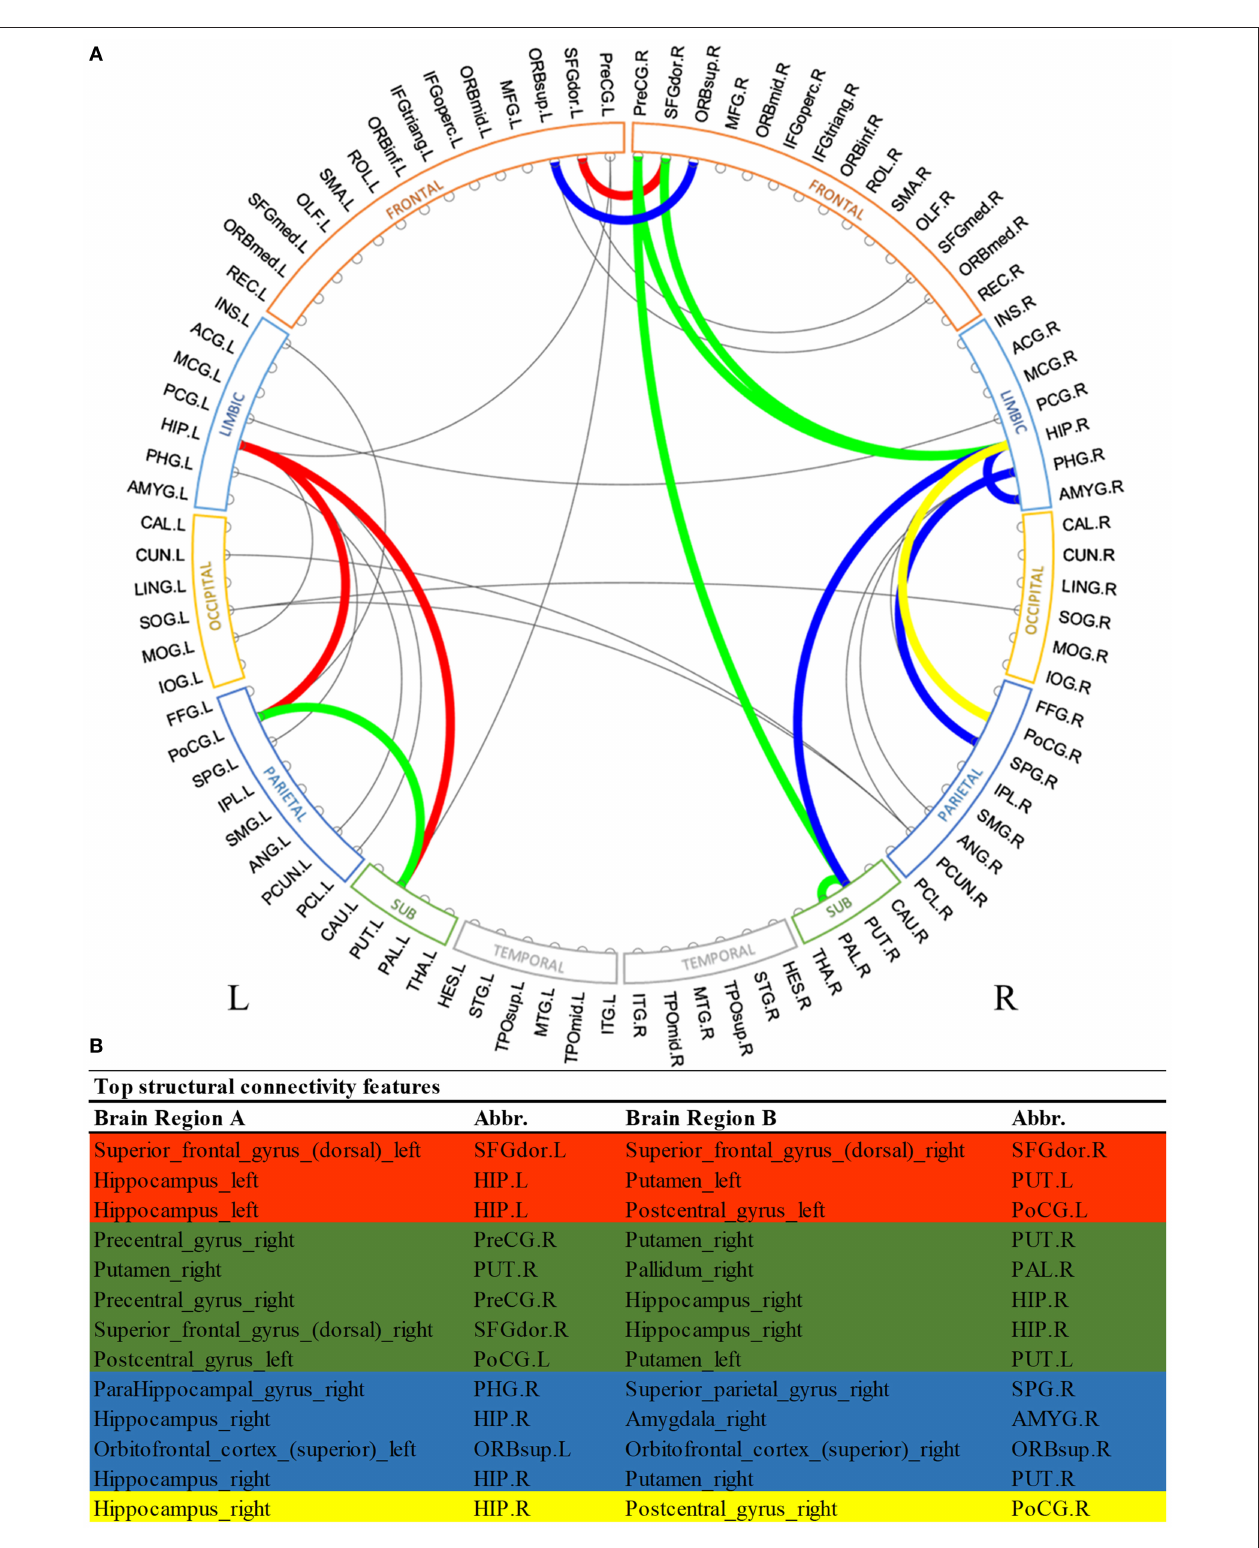
FIGURE 3 | Top discriminative region-to-region structural connections for early prediction of cognitive, language, and motor deficits. (A) circos plot visualization; (B) Full names and abbreviations table. Three common connections were identified to be important for the prediction of all three deficits (red); eight common connections were identified to be predictive of both cognitive and language deficits (red and green); seven common connections were identified to be predictive of both language and motor deficits (red and blue); and four common connections were identified to be predictive of both cognitive and motor deficits (red and yellow).